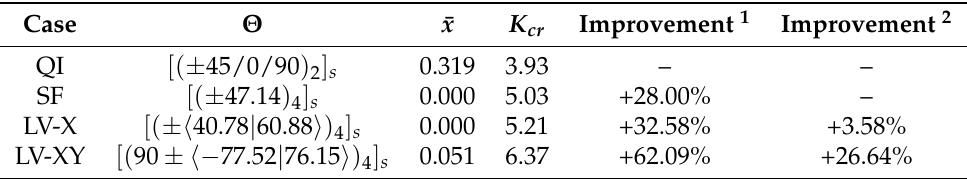
Table 8. Optimal designs and results of the stiffened plate with a central cutout subjected to pure in-plane bending displacements (w/o AFP manufacturing